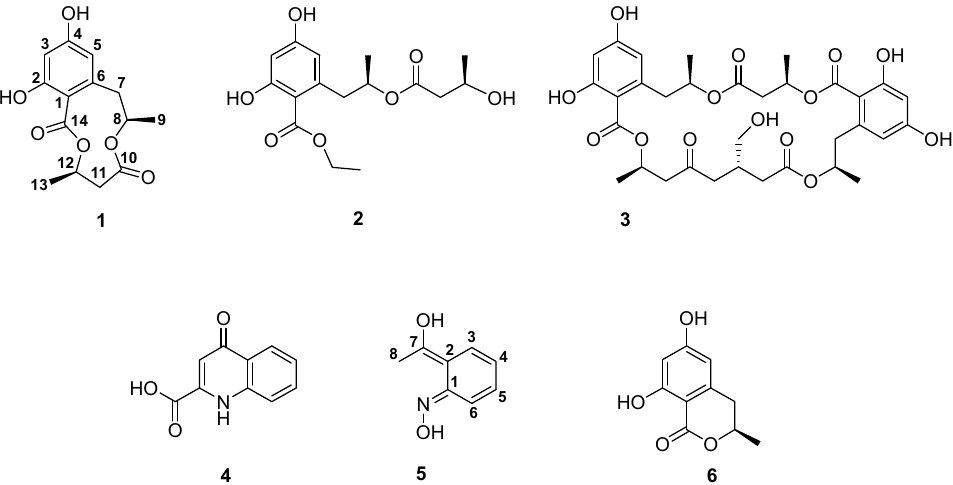
Figure 1. Talaromyces stipitatus obtained secondary metabolites: talarodioxadione 1 , talapolyester G 2 , 15G256 α 3 , transtorine 4, talarooxime 5 and 6-hydroxymellein 6 .